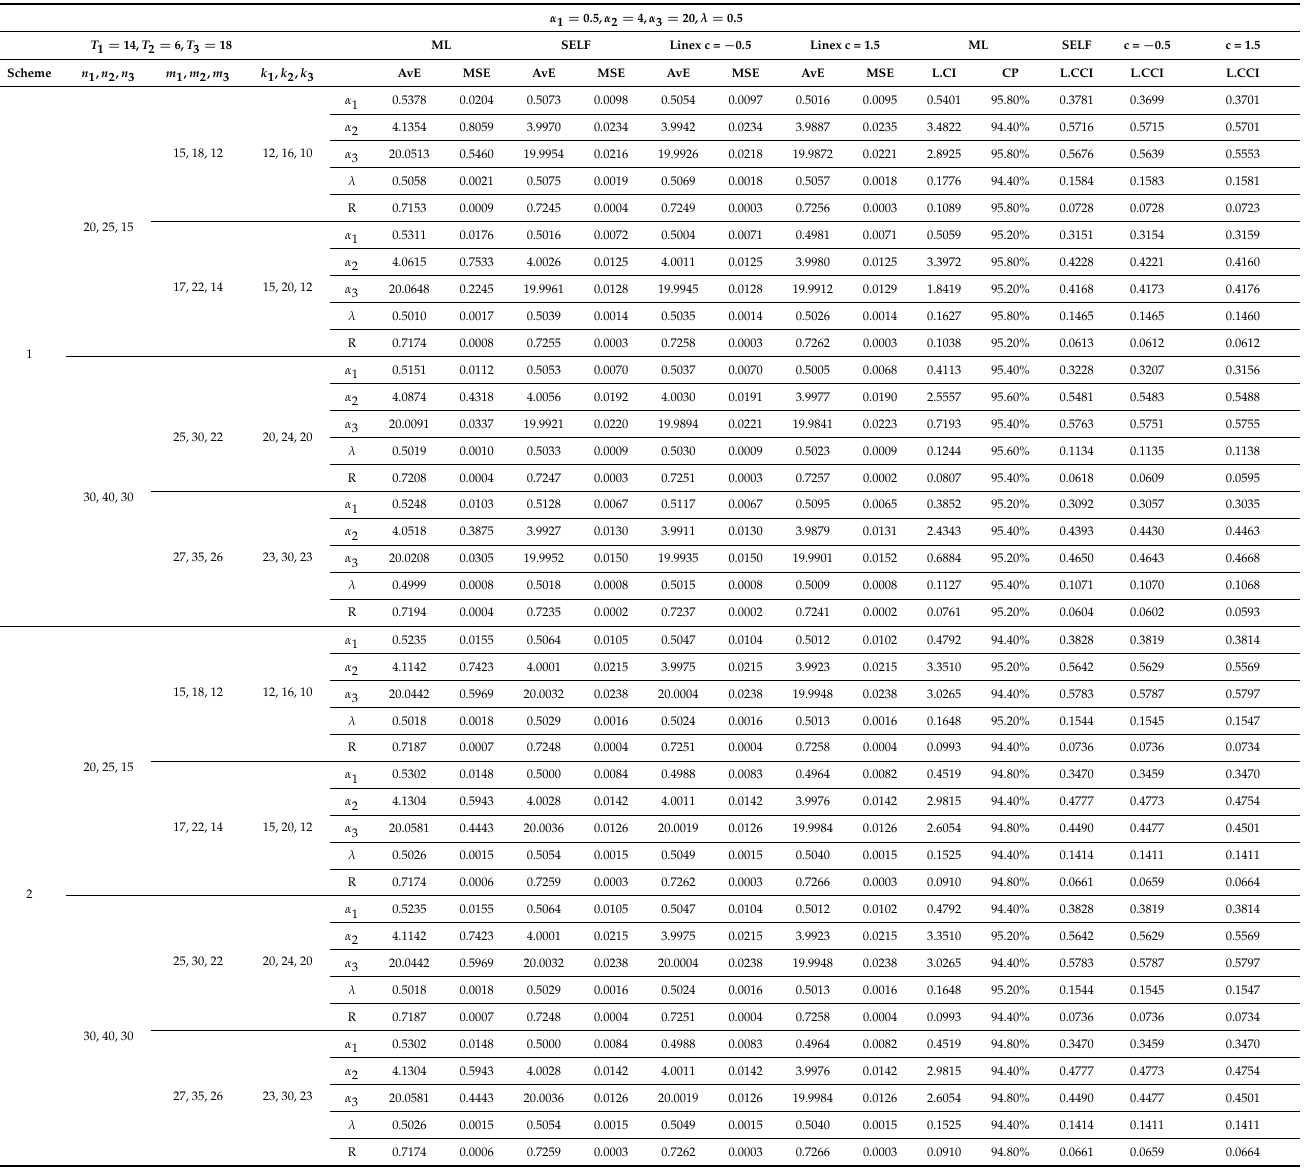
Table 2. AvE and MSE for estimation methods: Case